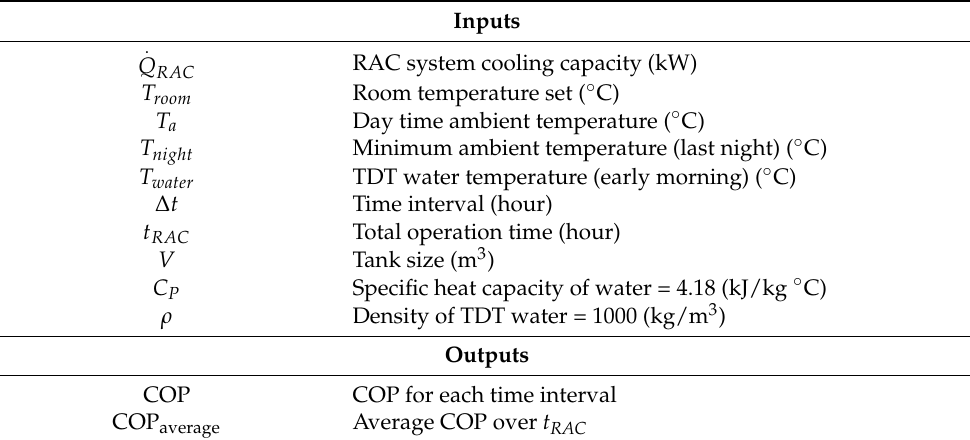
Table 1. Inputs and outputs of performance simulation (mathematical)